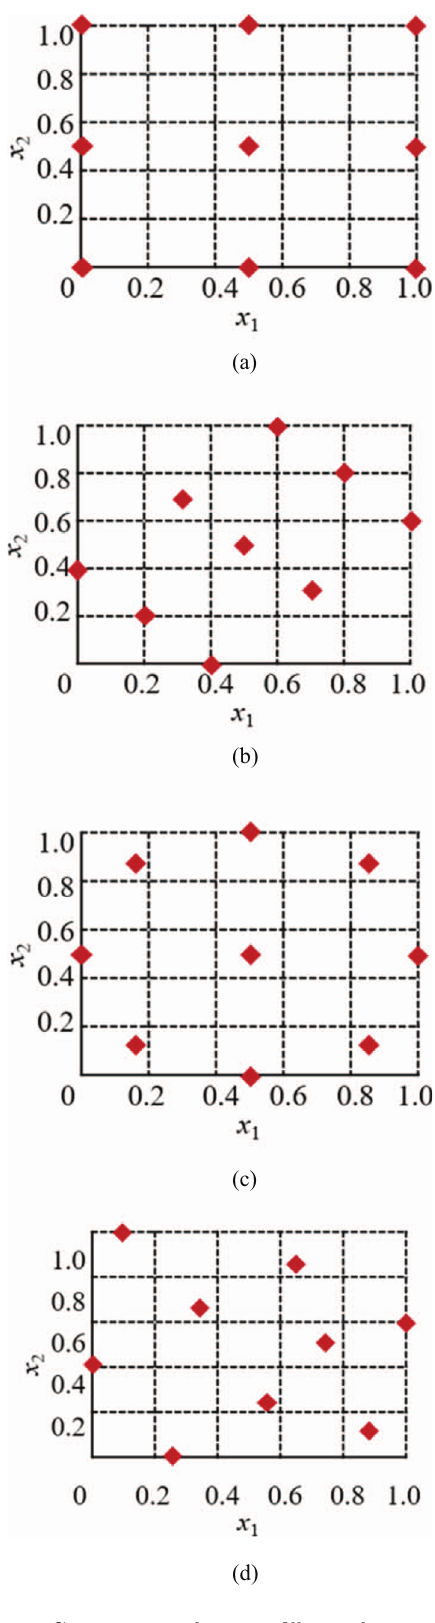
Figure 4. Comparison of space fi lling of various sampling methods. (a) 3-level full factorial design; (b) center composite design; (c) uniform design; (d) Latin hypercube